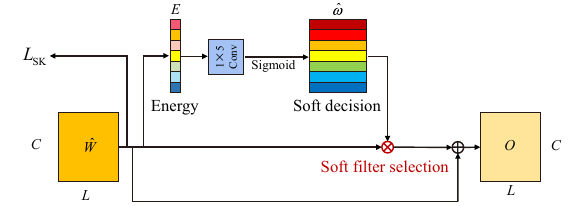
Figure 8 Index-based soft filtering